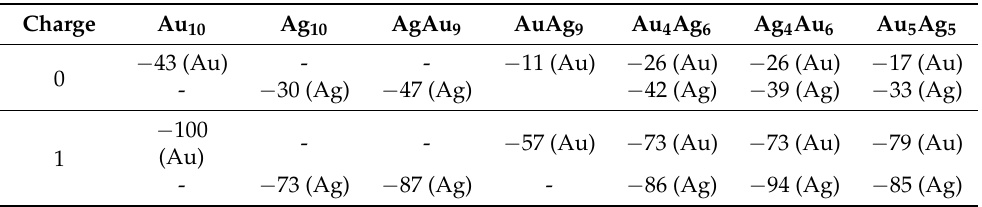
Table 4. Calculated energies of octanol adsorption on Au x Ag y (x + y = 10) in kJ/mol. Sites of octanol coordination (Au and Ag) are in